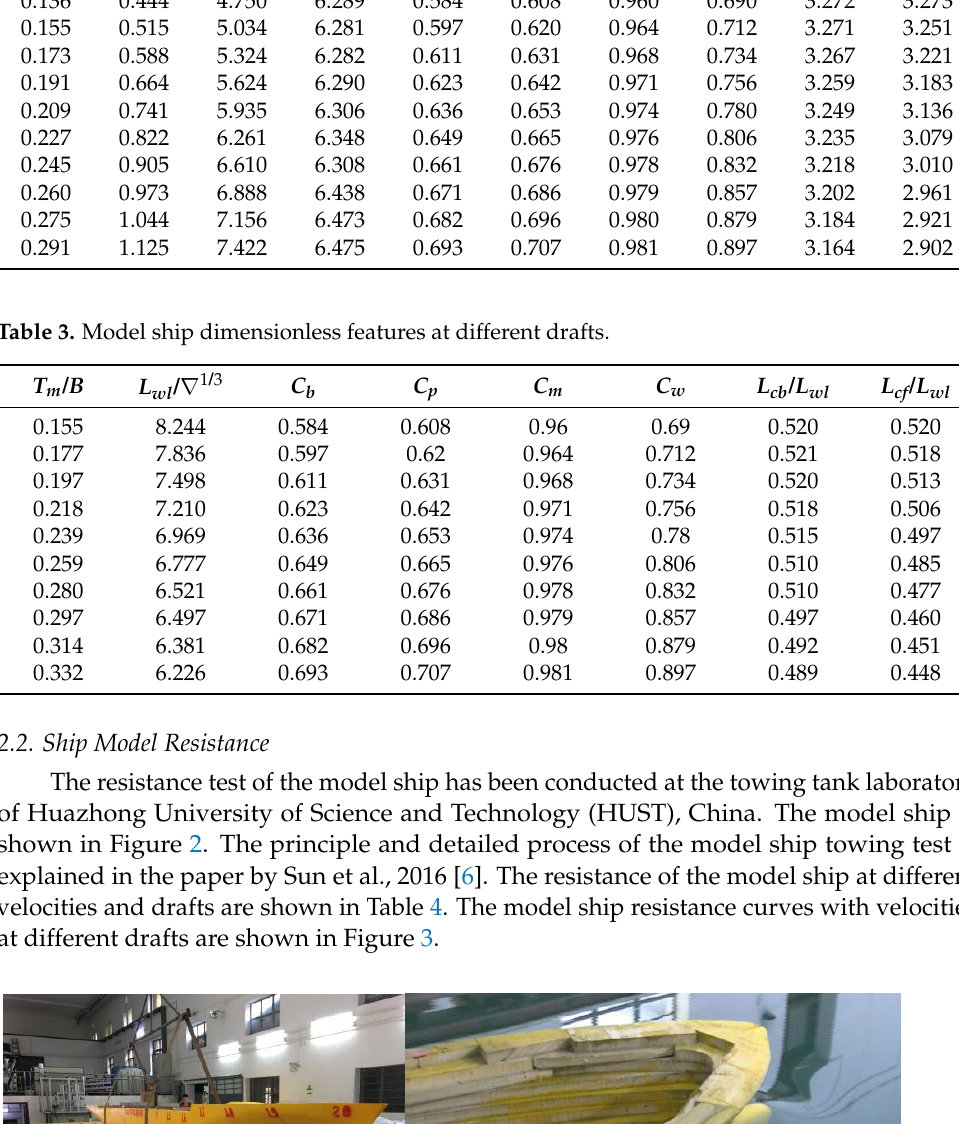
Figure 3. The model ship resistance changes with velocities at different drafts. Table 4. Model ship resistance at different speeds and drafts. T m (m)